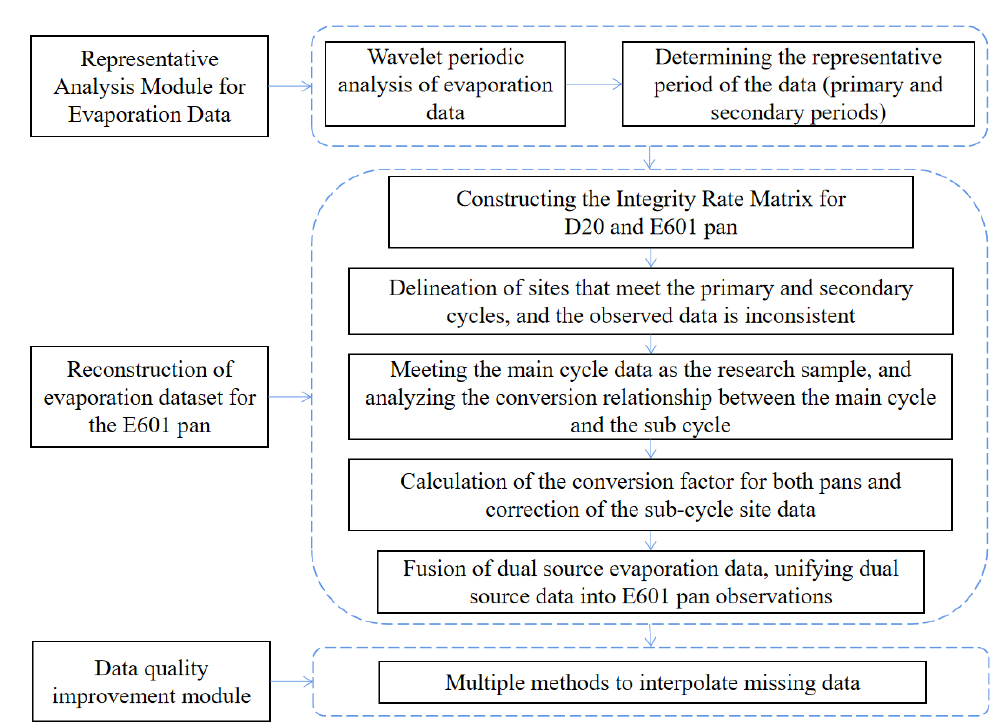
Figure 4. Practical application steps of governance and improvement method for dual-source evapo- ration